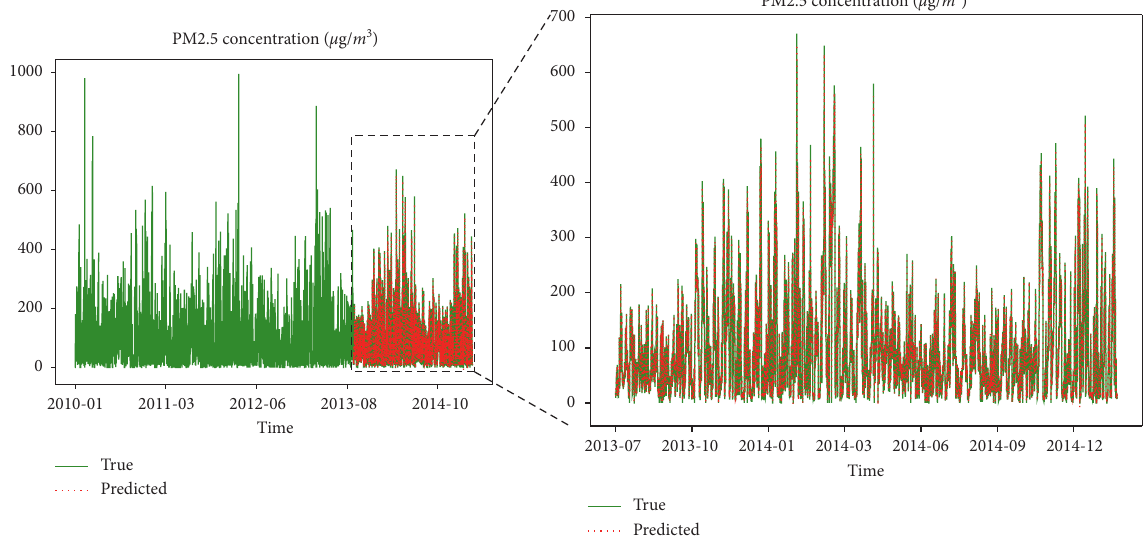
Figure 9: PM2.5 concentration prediction with TL from temperature.